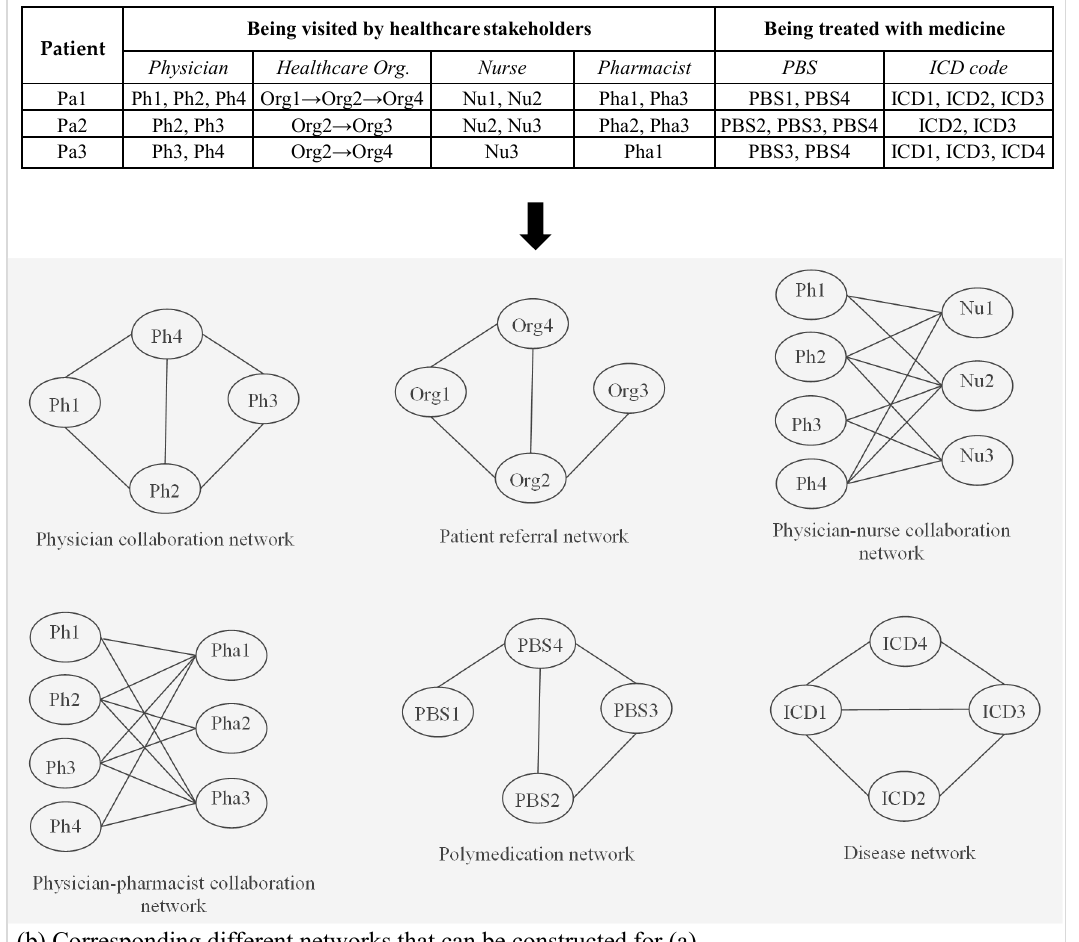
Figure 3. Construction of different networks based on an abstract administrative health dataset for three patients: ( a ) treatment information by different stakeholders; and ( b ) corresponding different healthcare stakeholder networks. Here Pa stands for patient, Ph for physician, Org for organisation that provides healthcare to patients, Nu for nurse, Pha for pharmacist, PBS for pharmaceutical benefits scheme and ICD for international classification of diseases.